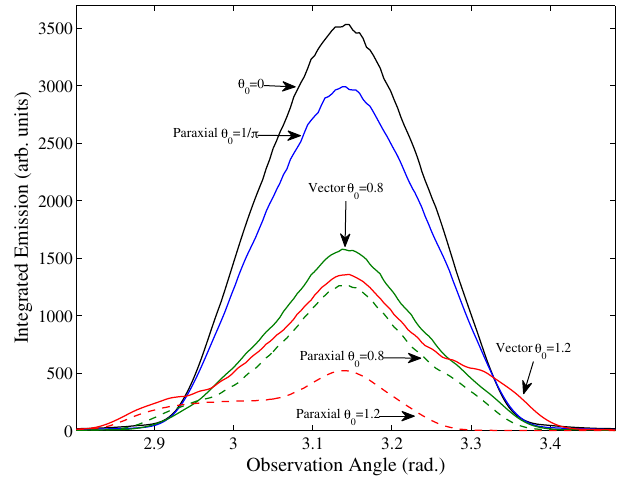
FIG. 14. Angular emission spectra integrated over all frequen- cies for fields of different focusing. In all cases the laser has a peak a 0 ¼ 2 , λ ¼ 0 . 8 μ m and has an envelope function that is 10 cycles in duration. The incoming electron has an initial γ 0 ¼ 10